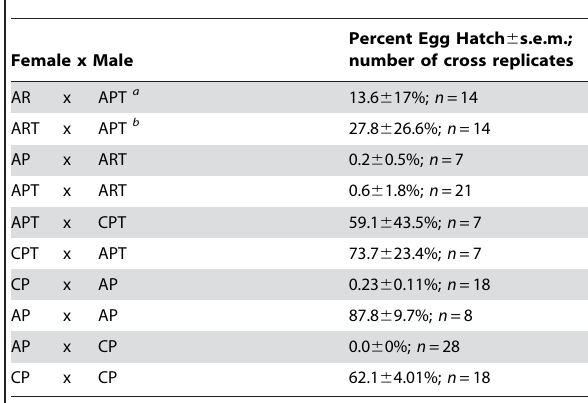
Table 1. Crosses and Pattern of Cytoplasmic